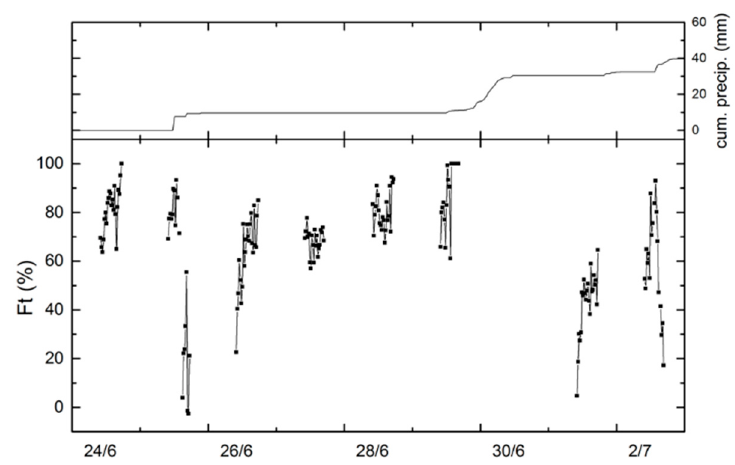
Figure 7. Twenty-minute values of the fraction of transpiration ( Ft) using the isotope method for the entire experimental period and cumulative precipitation.